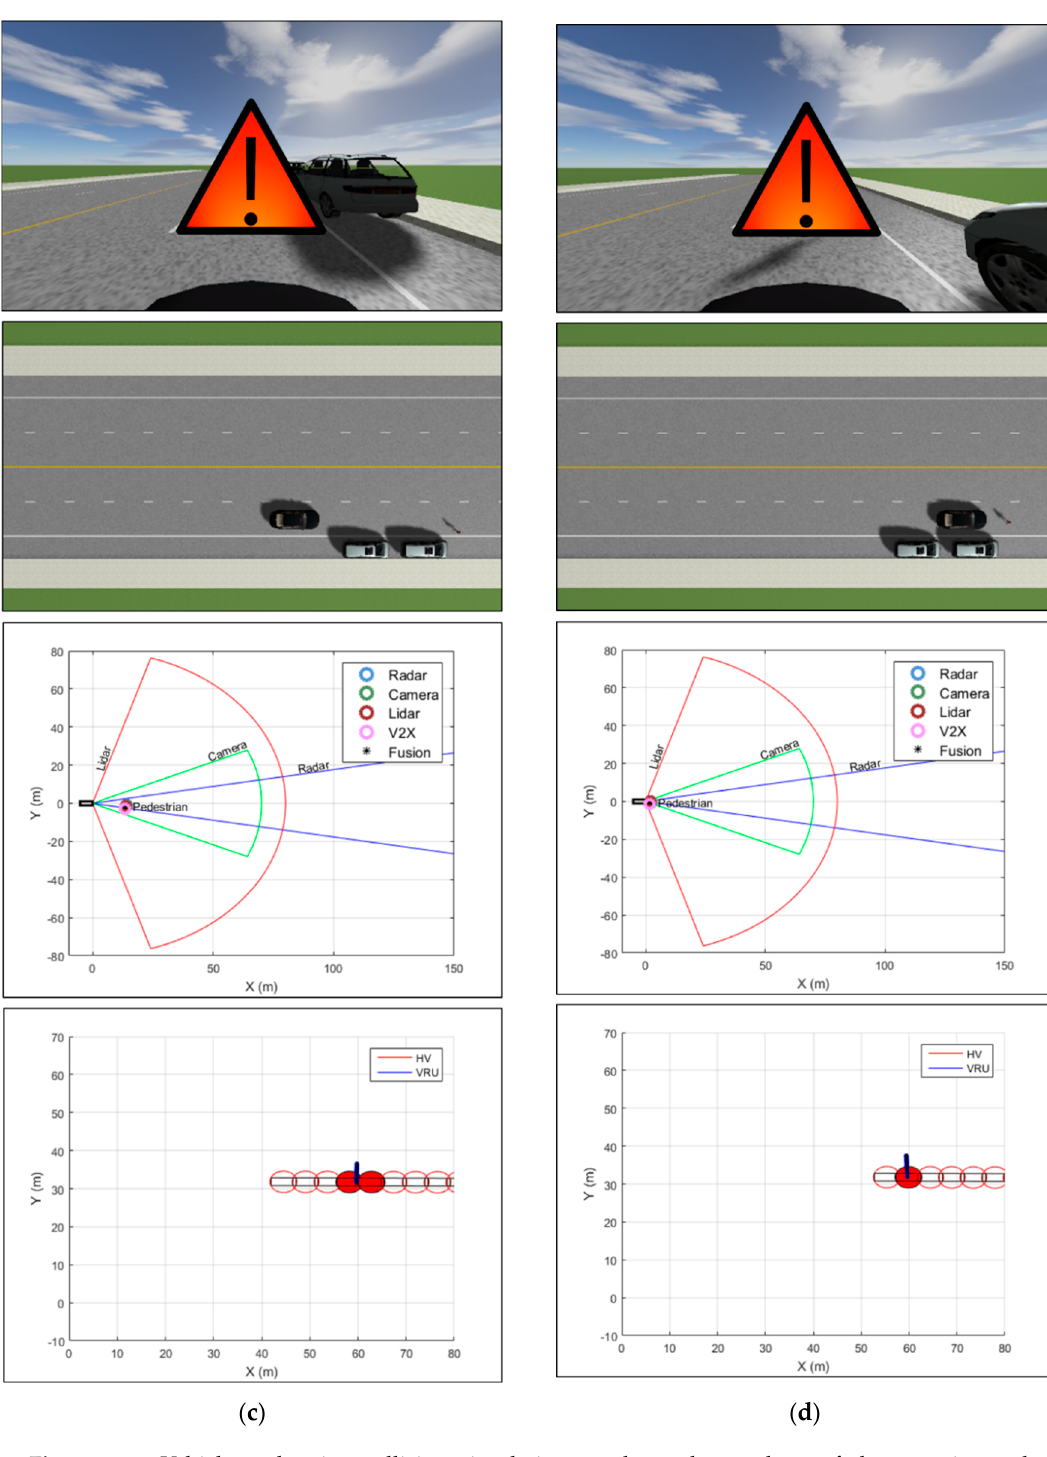
Figure 11. Vehicle–pedestrian collision simulation results and snapshots of the experimental environment at different time points. Shown in the center of the forward-looking view image is the visual collision warning generated to the host vehicle. The bird’s-eye-view image of the road scene shows the locations of the host vehicle and the pedestrian at the corresponding time instance. The sensor fusion image shows the filtered measurements from various sensors as well as the fusion result. Trajectory prediction and risk assessment enable detection of potential collision location, which is represented by a circle colored in red. ( a ) Results for 𝑡 = 0.7 s ; ( b ) results for 𝑡 = 1.4 s ; ( c ) results for 𝑡 = 2.1 s ; ( d ) results for the time point just before the collision.